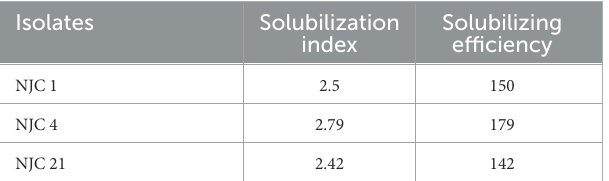
TABLE 2 Phosphate solubilization by some isolates from rhizosphere soil of Anethum graveolens L. Isolates